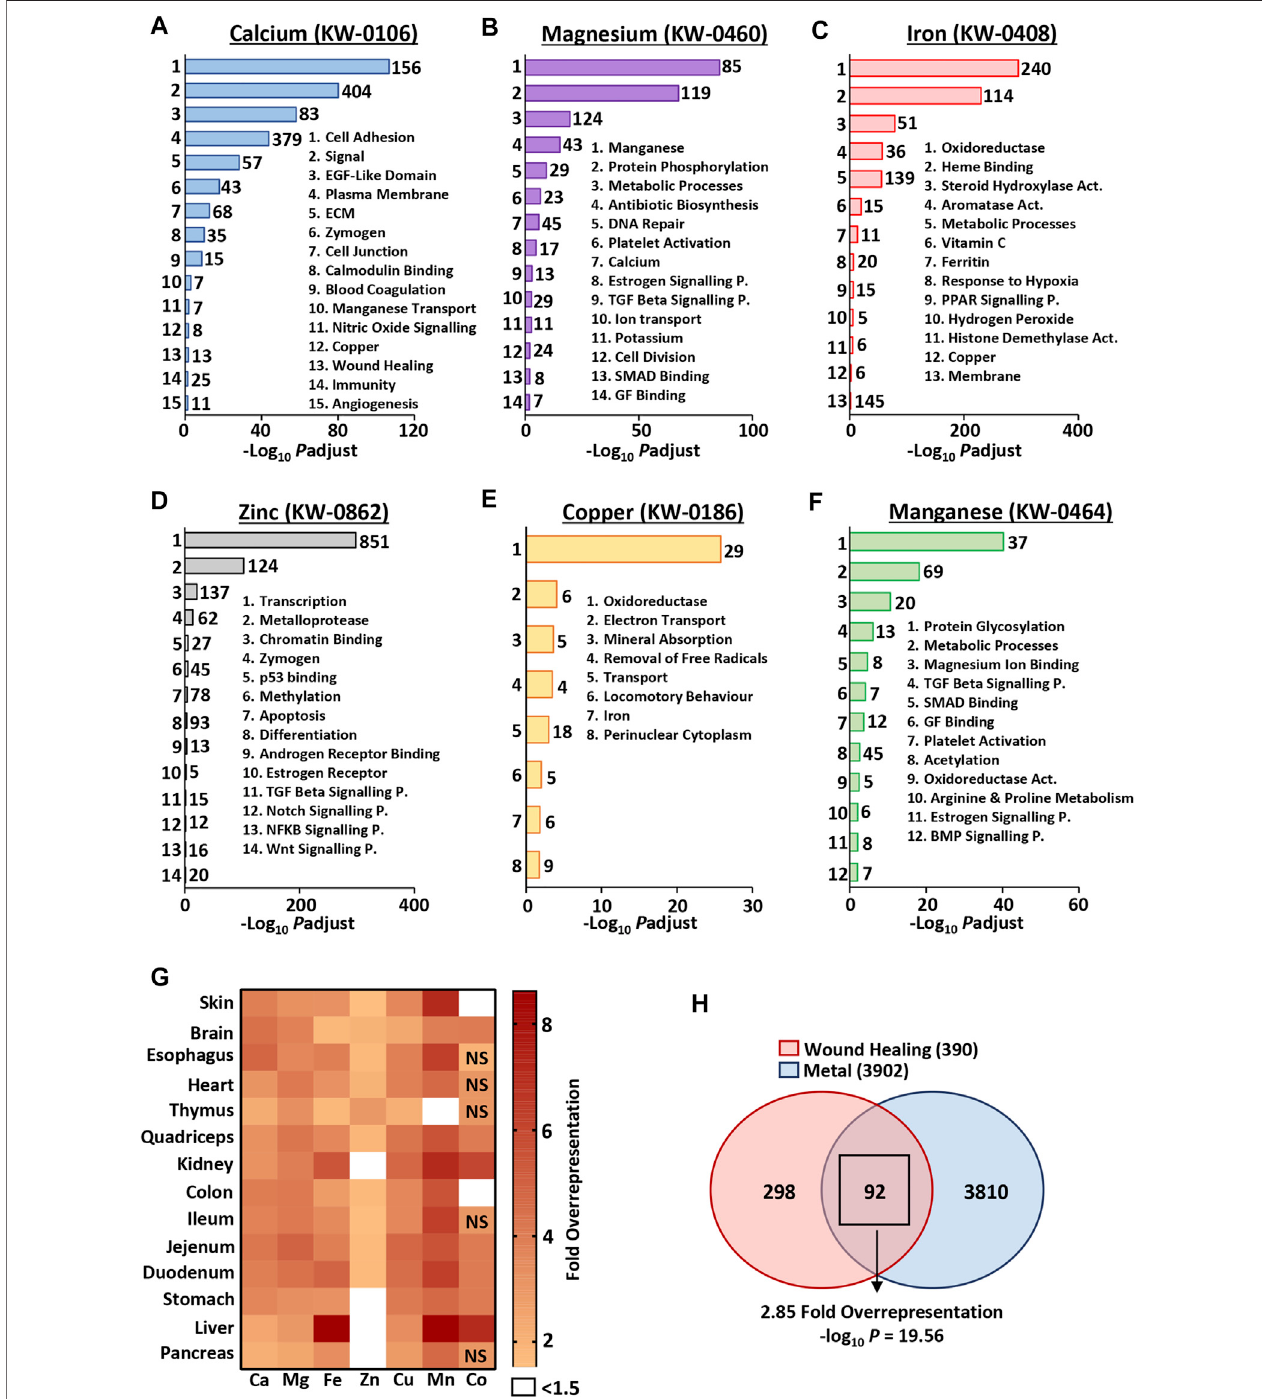
FIGURE 2 | Metal-speci fi c genes are associated with biological processes independent of context. Functional annotation was performed on metal gene lists from theUniProtknowledgebase[KB (A – F) ],demonstratinghighannotationofprocesseslinkedtoskinandwoundhealing.KW,keywordidenti fi er;Numbersofgenes,leftof bars; ECM, extracellular matrix; P., pathway; Act., activity. The top 1,000 expressed skin and organ genes show differential overrepresentation of UniProt KB metal genes[observed vsexpectedfoldchange (G) ].Metalgenes(combinedUniProtKBlist)aresigni fi cantlyoverrepresentedinthewoundhealinggeneontologygroup [GO: 0042060; (H) ]. NS, non-signi fi cant; P adjust, Benjamini-Hochberg adjusted p value.